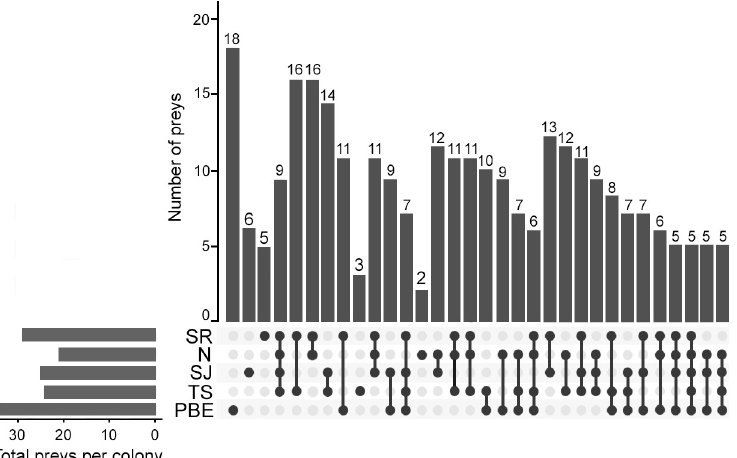
Fig 4. Number of unique and shared prey detected in the five harbor seal colonies. The bars on the bottom left represent the prey identified in each harbor seal colony. The upper bars represent the number unique or shared prey. The dark connected dots indicate the number of prey shared among the colonies. Not connected dots are unique prey. Data of consumed prey by harbor seal colonies from the islands Todos Santos (TS), San Jeronimo (SJ), Natividad (N) and San Roque (SR) were obtained from a previous study [9]. PBE = Punta Banda Estuary.